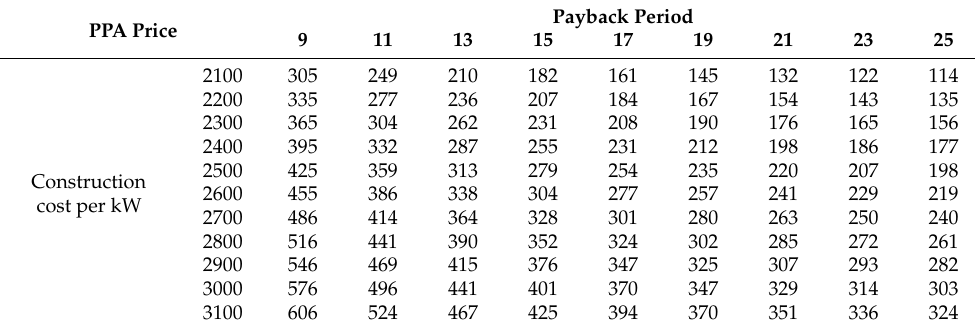
Table 2. Correlation analysis of unit kilowatt construction cost, investment payback period and PPA price (the result is PPA price).